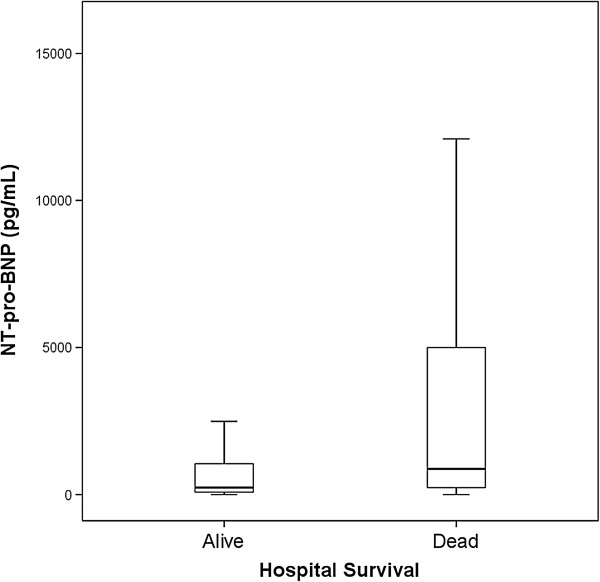
Box and whisker plots for hospital survival. The NT-pro-BNP level was significantly higher in nonsurvivors than survivors.